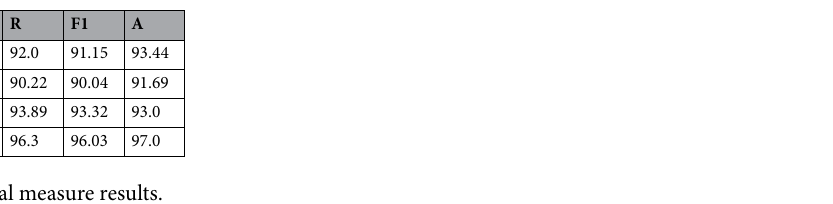
Table 2. Statistical measure